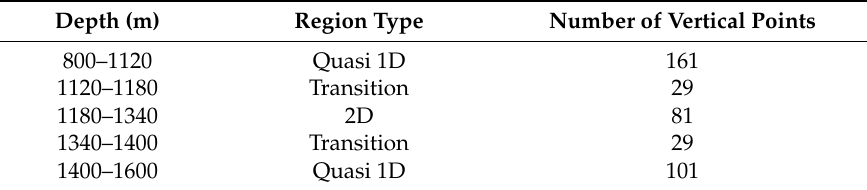
Table 1. A priori geological region type with respect to